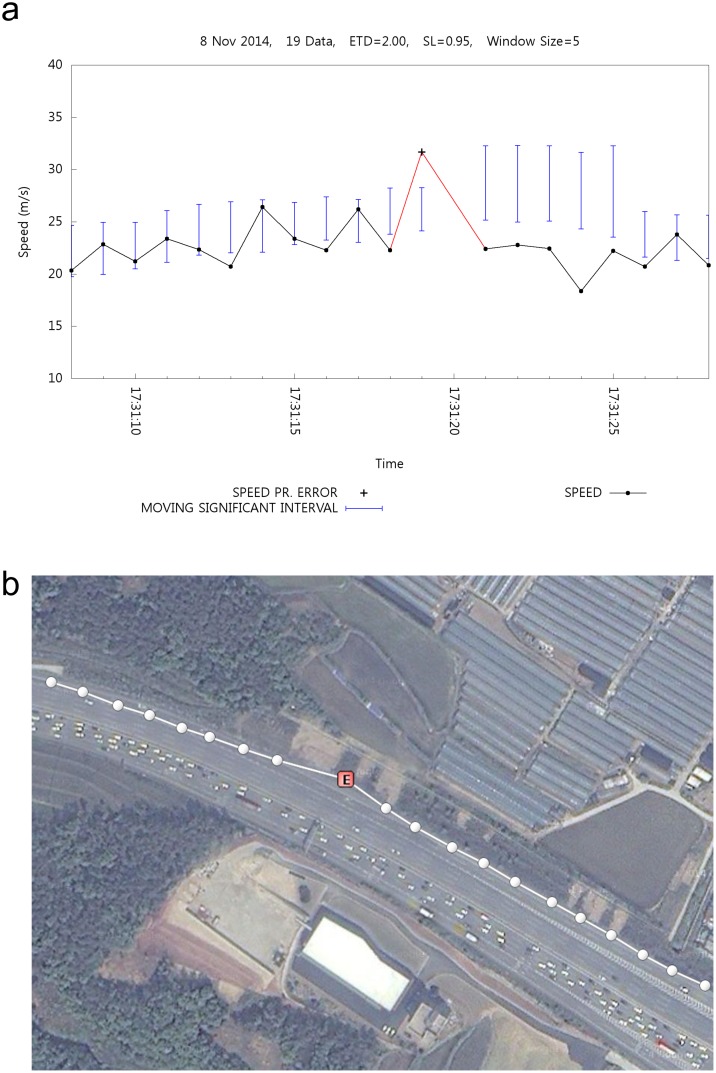
Speed Error Detection.